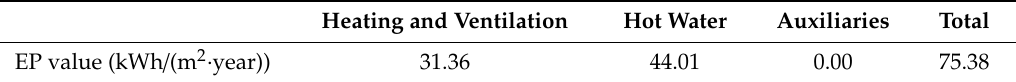
Table 12. The annual primary energy demand (kWh / (m 2 · year)) for the multi-family building at